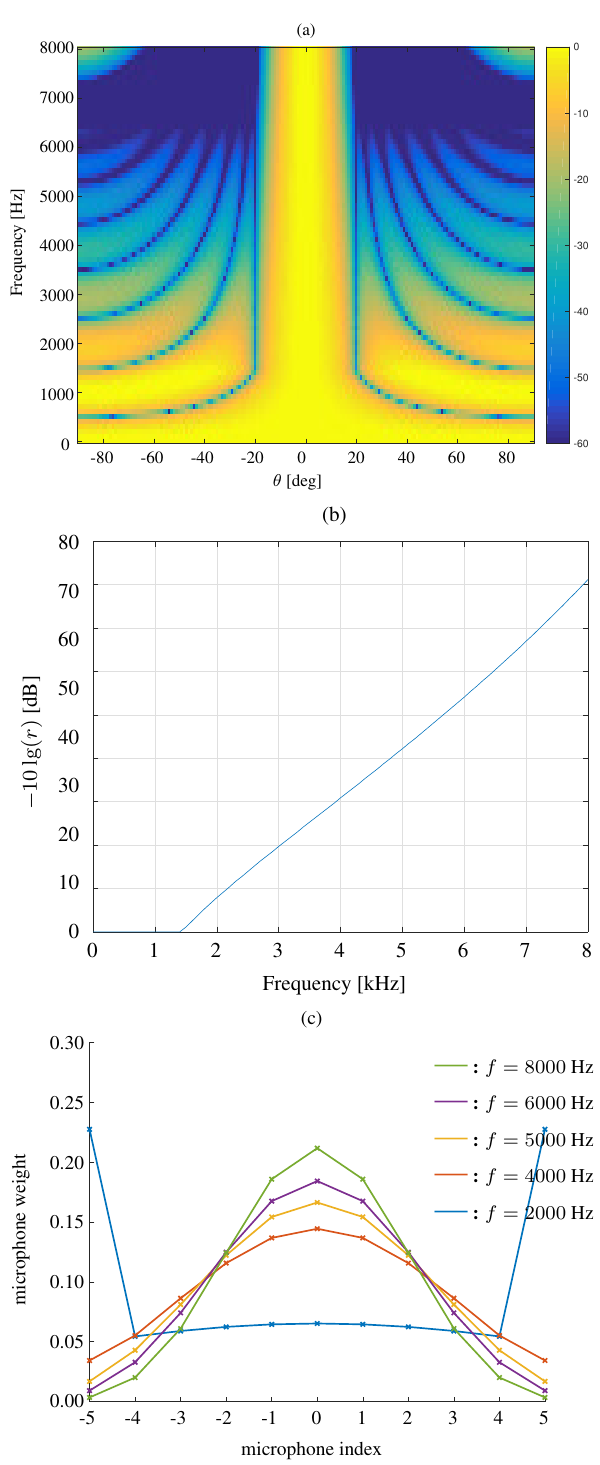
Figure 10. Constant beamwidth beamforming using the Chebyshev window-based method: ( a ) constant beamwidth beampattern, ( b ) the parameter r , ( c ) the weights of microphones for different frequency bins. The beamwidth is fixed to 40 ◦ , M = 11, δ = 3.5